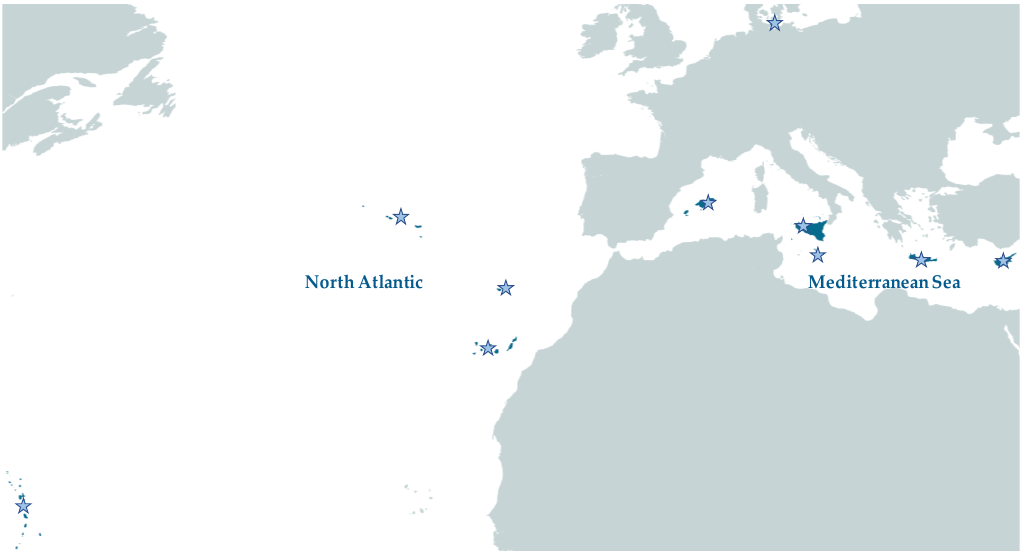
Figure 1. European islands selected for the study.